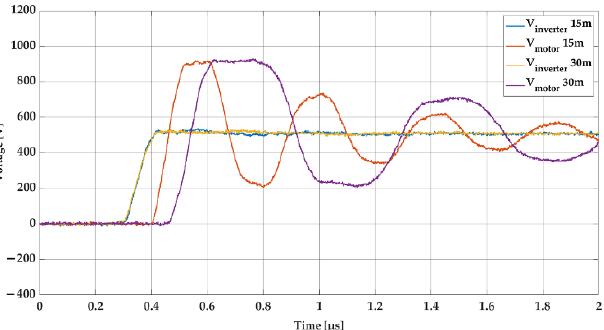
Figure 3. Voltage waveform across the inverter and the motor during the turn-off.